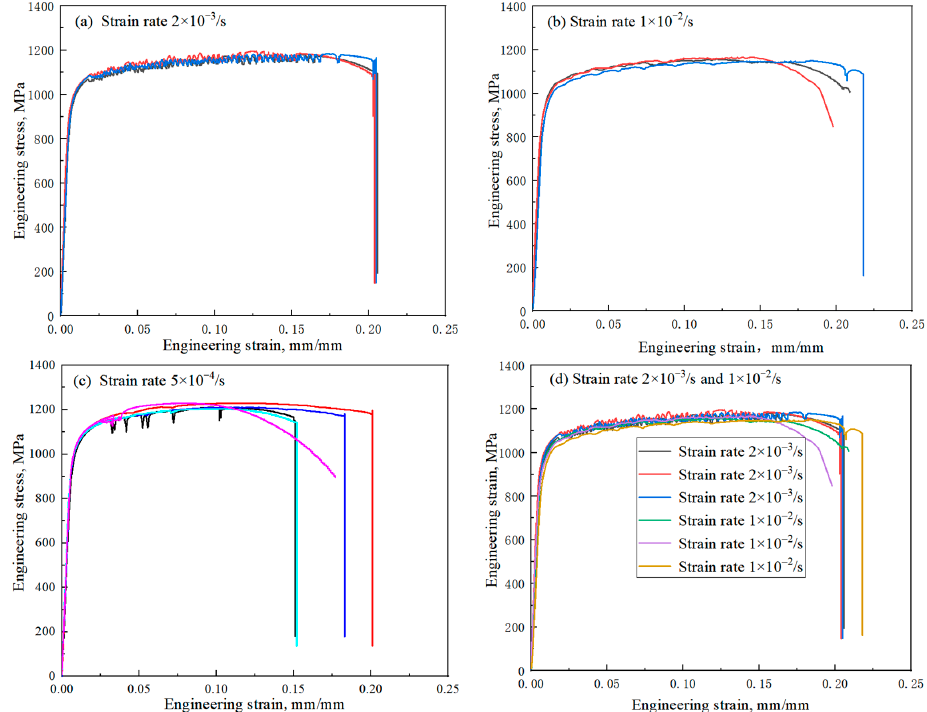
Figure 2. Tensile test results at different strain rates: ( a ) 2 × 10 3 /s; ( b ) 1 × 10 − 2 /s; ( c ) 5 × 10 − 4 /s; ( d ) 2 × 10 − 3 /s and 1 × 10 − 2